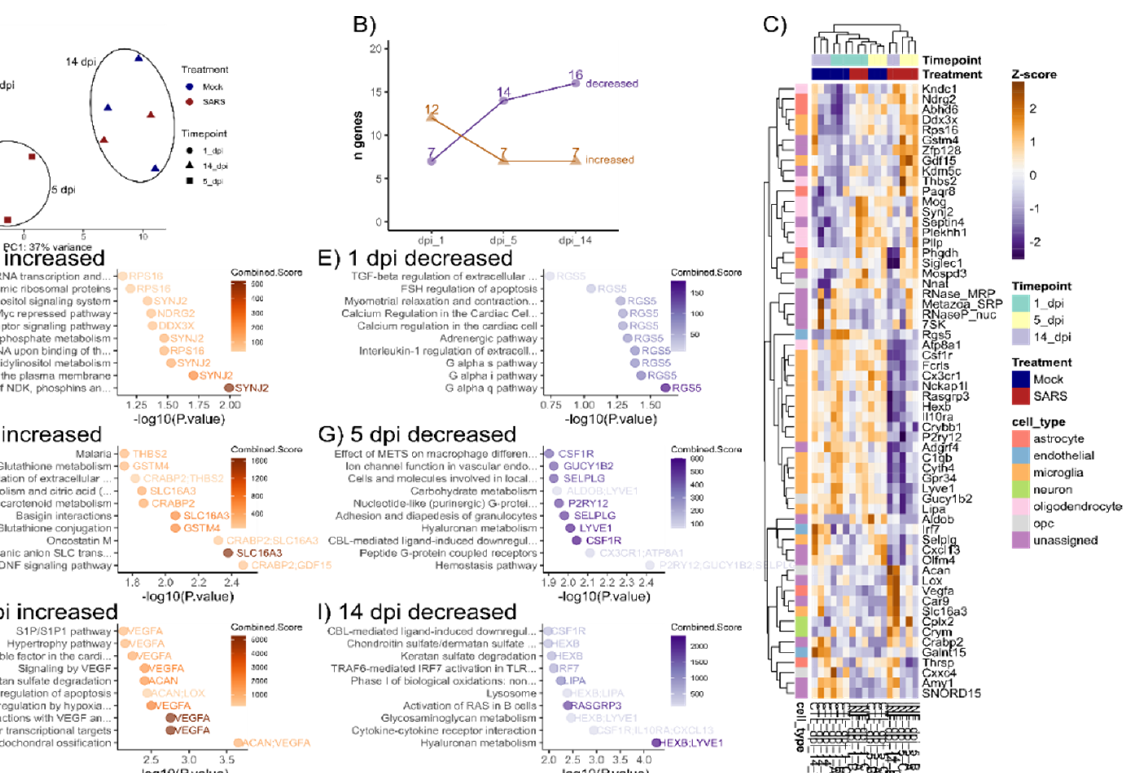
10 of 16 heads (red); ( B )) or -sense (magenta arrowheads (yellow); ( B )) viral RNA strands. Nuclei were coun- terstained with DAPI/ blue; merge depicts a composite image. Scale bar = 10 µm. We also calculated the corrected total intensity of each marker to compensate for background fluorescence (Supple- mentary Figure S4). Additionally, since both β 3-Tubulin and Map2 were cytoskeletal markers, we used NeuN, a nuclear marker for neurons, to prevent unconscious observational bias of the surro- gate markers we used. We found no overlap in fluorescence signals from probes identifying SARS- CoV-2 and NeuN. These data further confirm our observation that SARS-CoV-2 does not infect hamster neurons in organotypic cerebellar brain slices. 3.3. Transcriptional Differences Affiliated with Glia Were Detected in SARS-CoV-2-Treated Cerebellar Slice Cultures We used RNAseq to characterize any transcriptional differences in the cerebellar slices following inoculation with SARS-CoV-2 at 1, 5 and 14 DPI. As expected, PCA showed that differences between the samples such as the time in culture were significant (Figure 5A and Supplementary Figure S5). However, we were able to identify some tran- scripts that were altered in abundance in association with SARS-CoV-2 infection at each